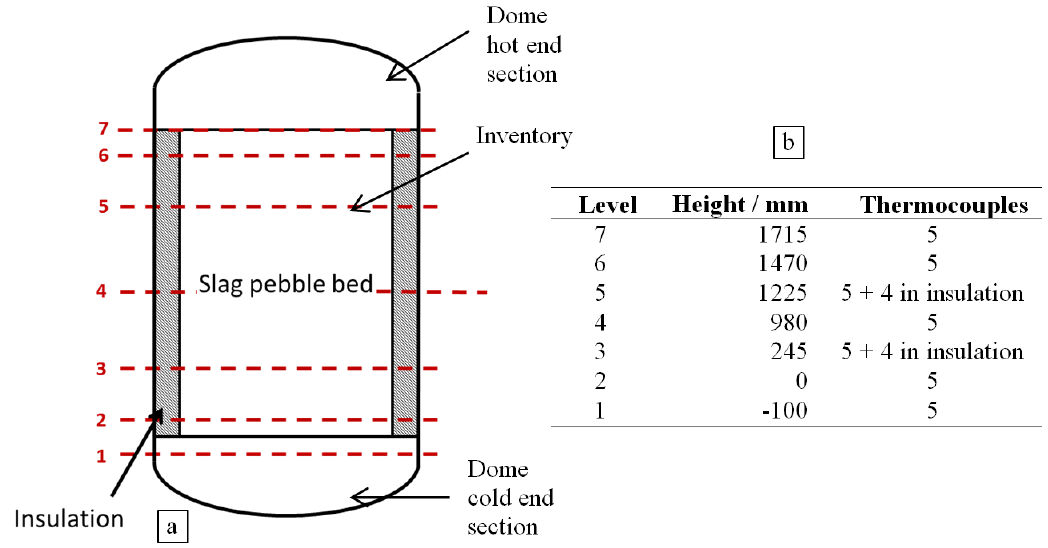
Figure 5. Schematic drawing of the thermal energy storage ( a ) with different levels of thermocouple placement ( b ) [27].